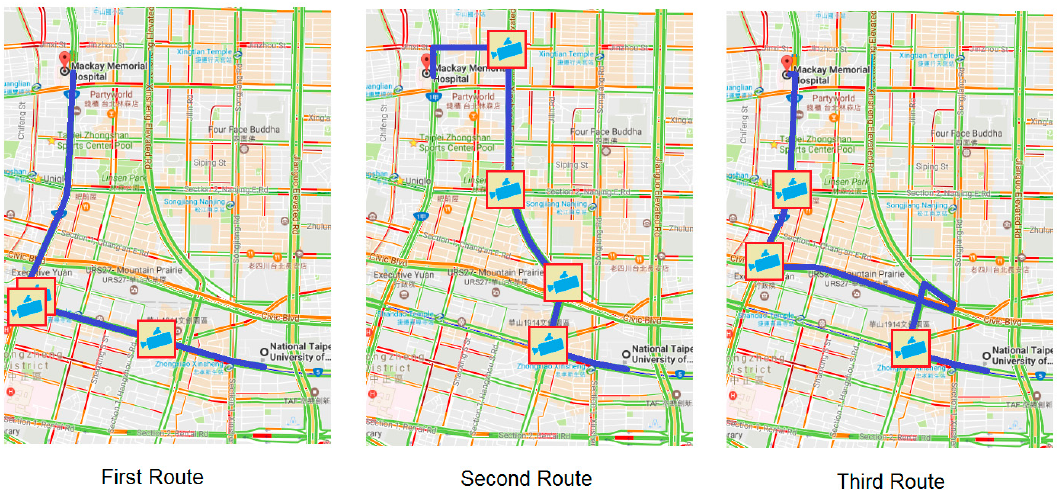
Figure 9. Delivery routes suggested by Google Maps and available CCTV camera icons.